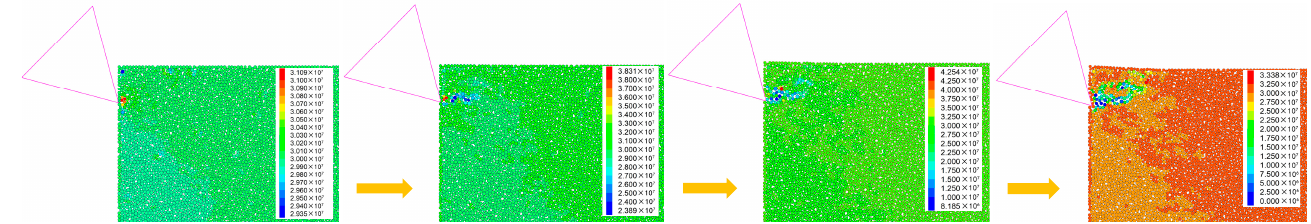
Figure 10. Pore pressure diffusion process (ambient pressure of 30 MPa).